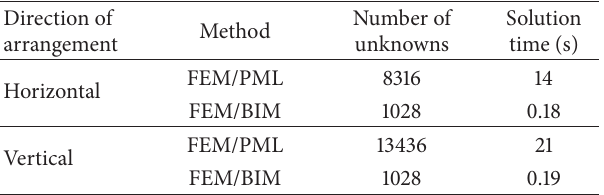
Table 1: Comparisons of solution time and number of unknowns for different